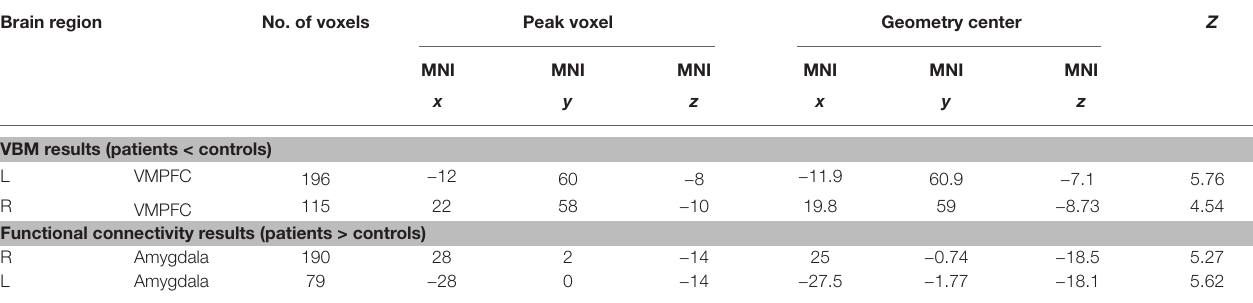
TABLE 2 | Summary of MRI results.